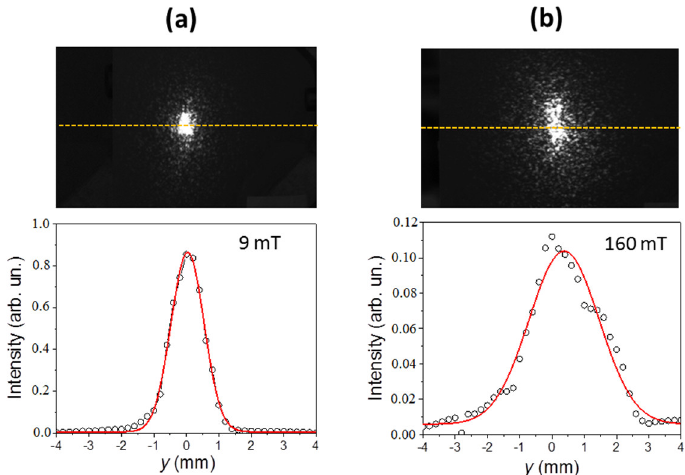
Figure 4. The optical reflection spot obtained by the reflection of a laser beam from the surface of a soft MAE with a 70 wt% of CIP exposed to a magnetic field of ( a ) B = 9 mT and ( b ) B = 160 mT. The upper images are the far-field reflection patterns observed on an opaque screen, and the lower images are intensity profiles measured along the yellow lines indicated in the upper images.